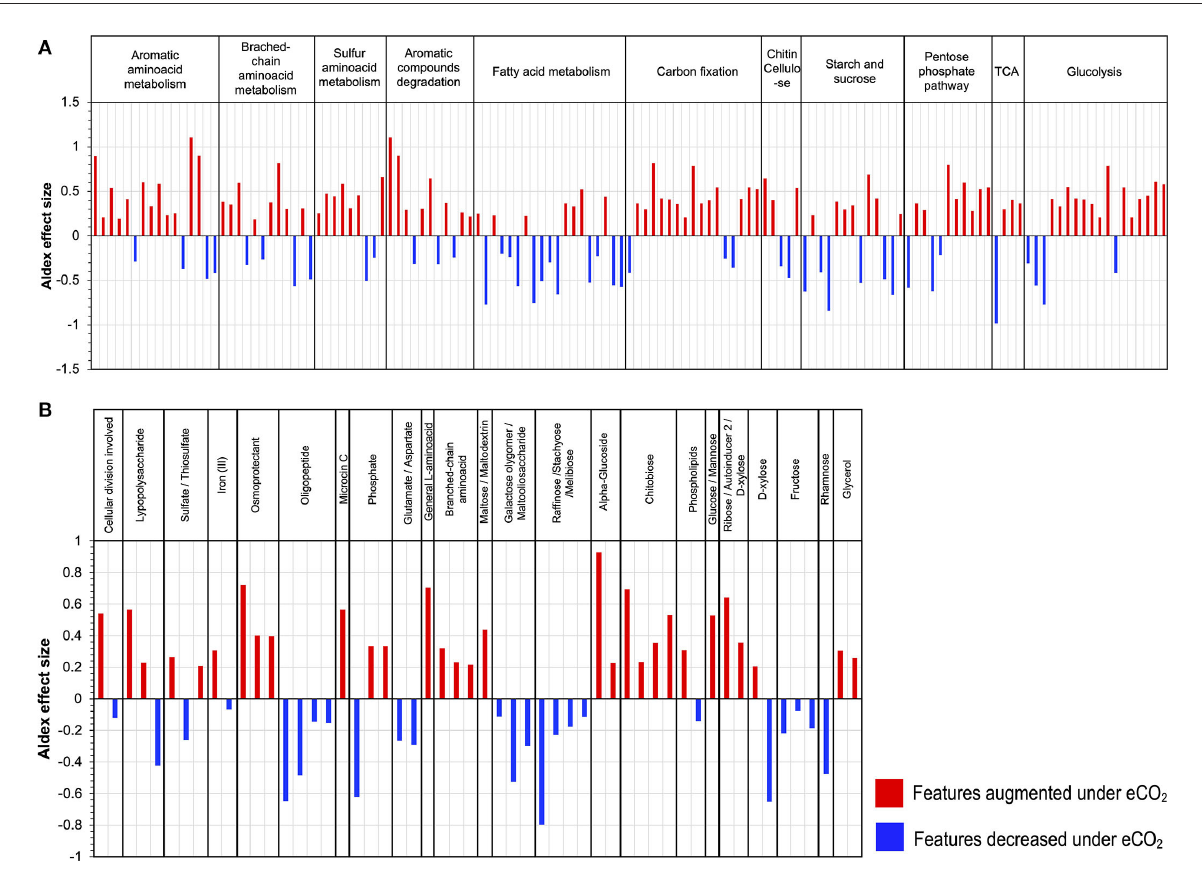
FIGURE6 Differential abundance of transcripts grouped by KEGG Orthology (KO) second level of (A) carbon compounds metabolism and (B) ABC